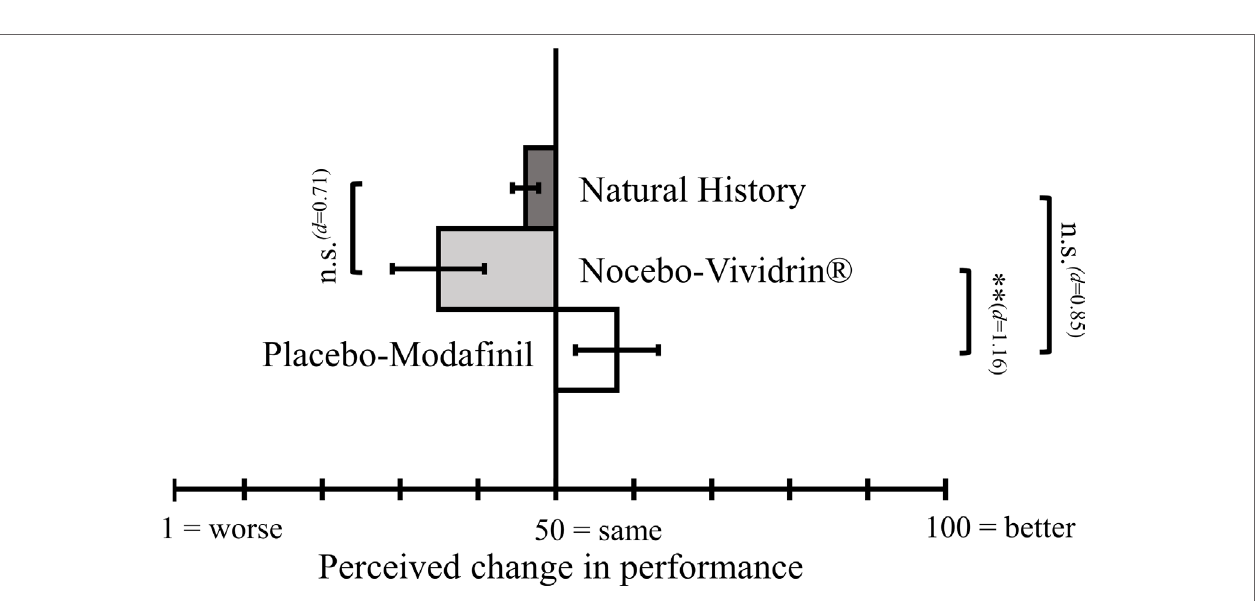
FIGURE 3 | Perceived change in performance (“How do you rate your cognitive performance now in comparison to the first assessment?”) using a 1–100 VAS (1 = “worse”; 100 = “better”). Error bars represent standard errors. ** p <